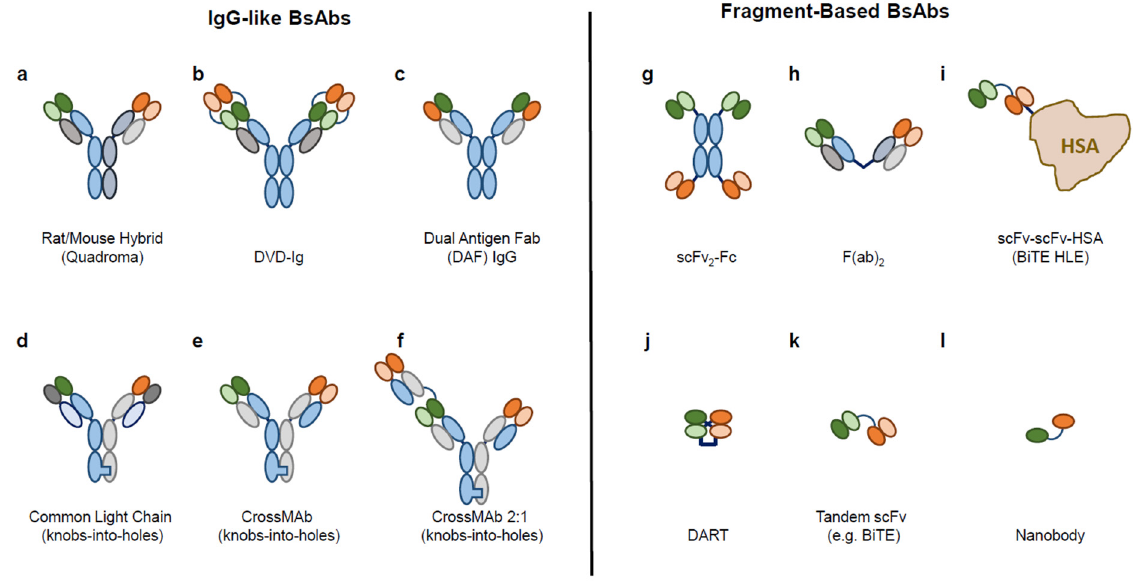
Figure 1. Examples of BsAb formats and structural diversity: ( a – f ) IgG-like BsAbs and ( g – l ) fragment-based BsAbs. DVD-Ig: dual variable domain immunoglobulin; scFv: single-chain variable frag- ment; Fab: antigen-binding fragment; HSA: human serum albumin; BiTE: bispecific T-cell engager; HLE: half-life extended; DART: dual-affinity re-targeting antibody.